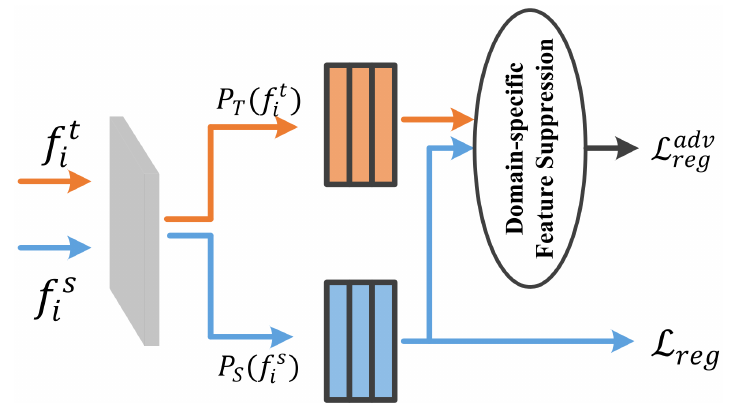
Figure 5. The feature suppression